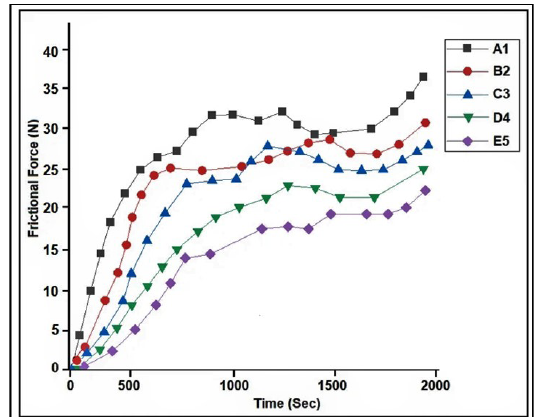
Figure 4. Friction force at 30N Load and 3 m/s sliding velocity.